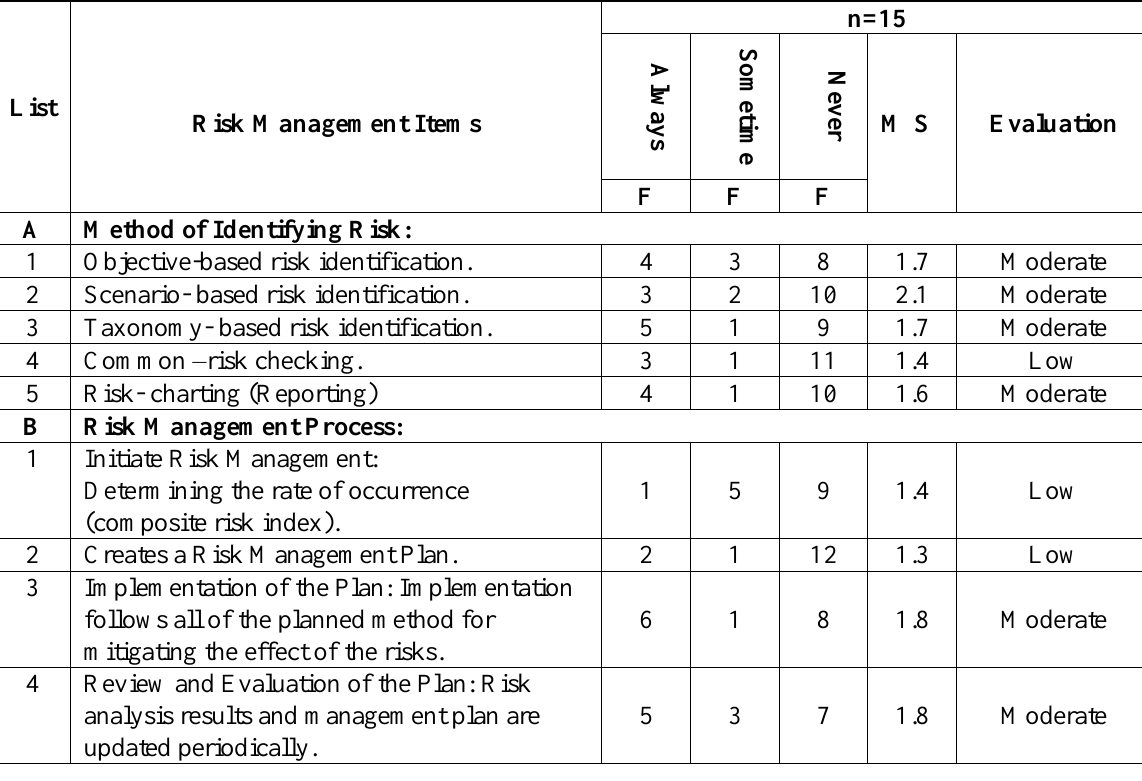
Table (2): Mean of Scores on Items of Risk Management at Model Primary Health Care